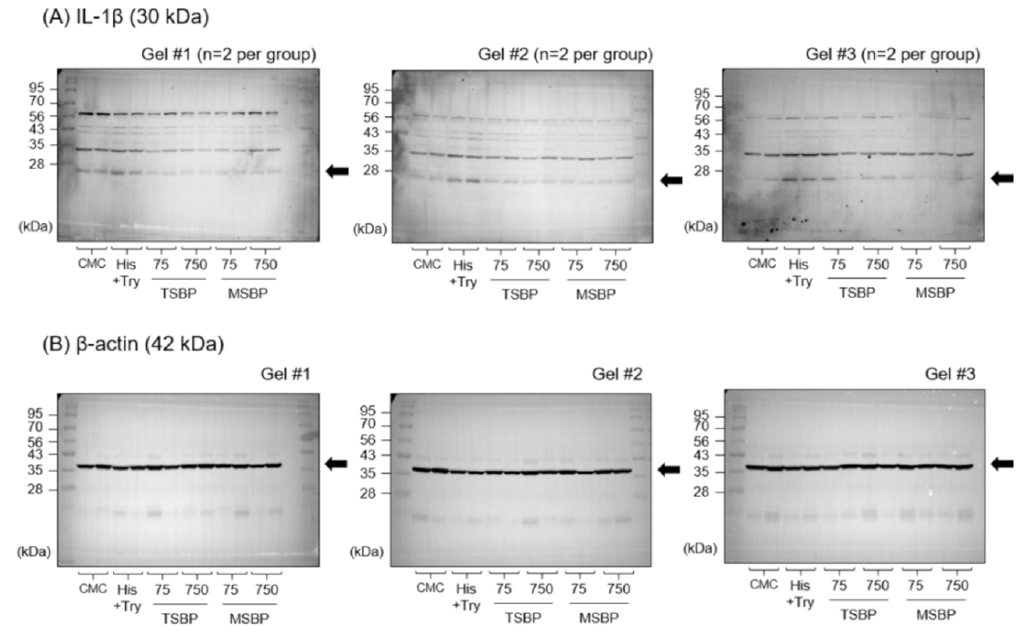
Figure A3. The full-length Western blot images corresponding to Figure 6A. ( A ) IL-1 β . ( B ) β -actin for IL-1 β . The arrows indicate the appropriate molecular weight of each